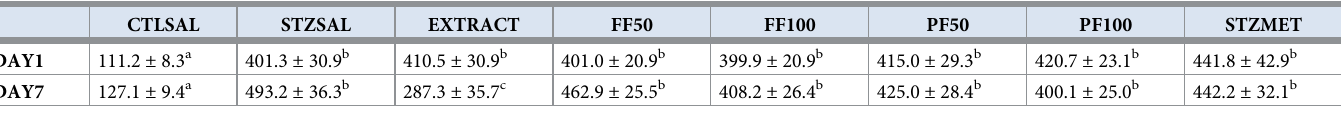
Results expressed as means ± SEM. Different letters indicate significant differences (ANOVA followed by Tukey’s post-test , n = 8, p < 0.05).